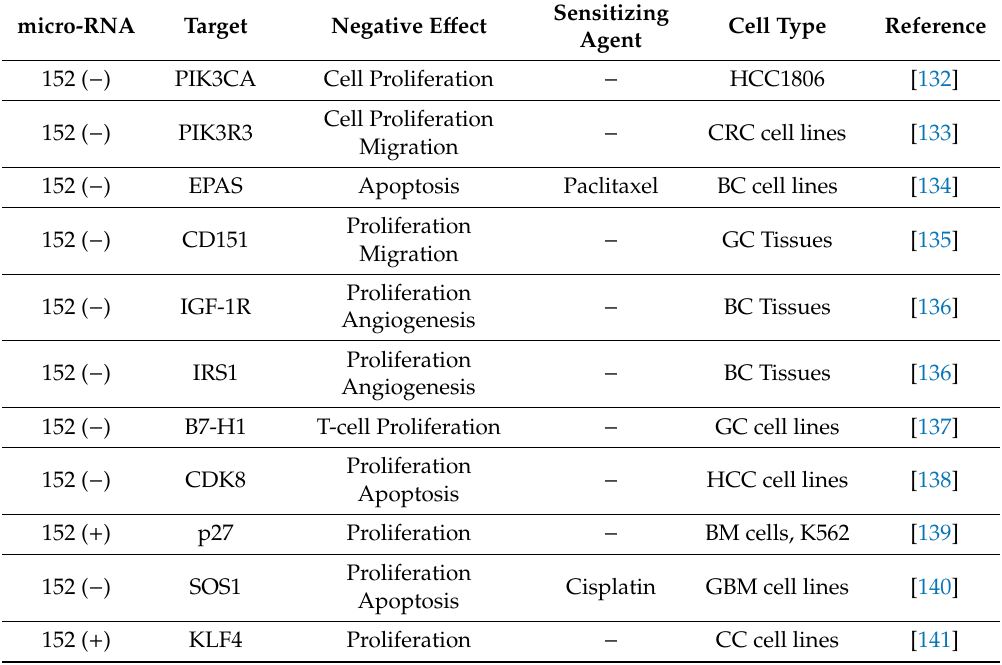
Table 5. Elevated ( + ) or reduced ( − ) miRNA-152 levels are shown, as are their target genes, their biological e ff ects and whether these factors can sensitize cells to certain therapeutic agents. The cell types indicate the types of cells characterized. BC, breast cancer; GC, gastric cancer; CRC, colorectal cancer; BM, bone marrow; GBM, glioblastoma; HCC, hepatocellular carcinoma; CC, colon